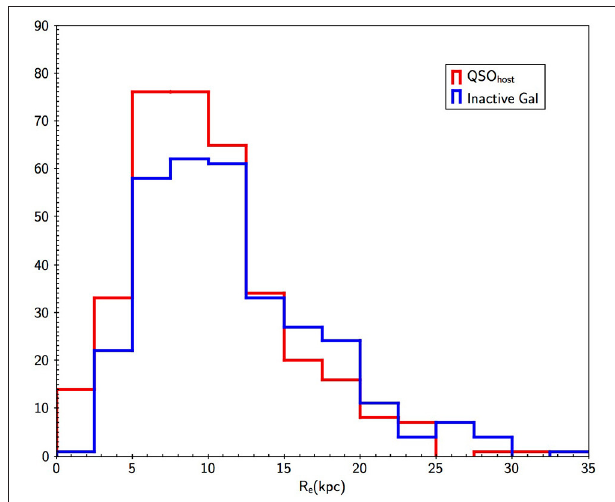
FIGURE 2 | Distribution of effective radius R e for quasar hosts (red line) and that of a sample of inactive galaxies (blue line) that have similar luminosity and redshift of quasar hosts.